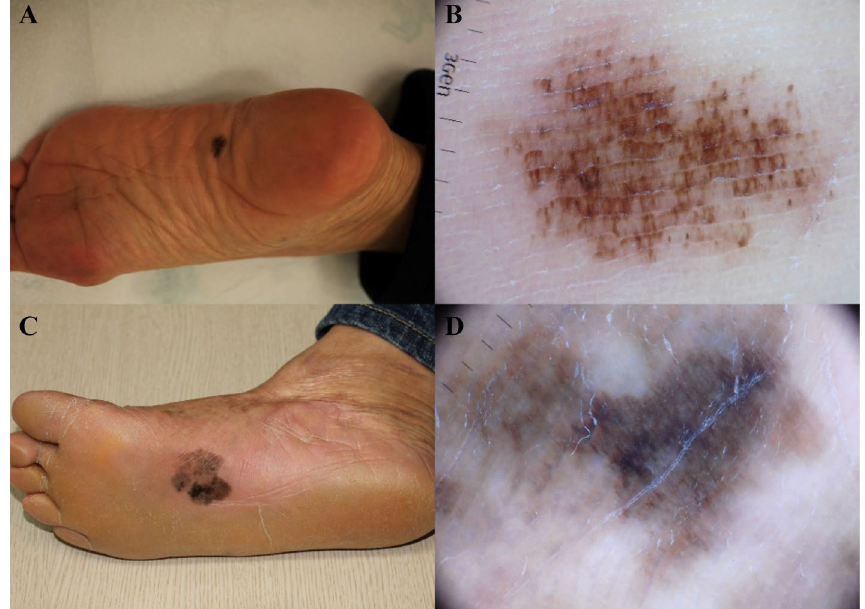
Figure 1. Clinical and dermoscopic features of acral lentiginous melanoma in situ (ALMIS): small versus large ALMIS. (A,B) The 12-mm ALMIS showed asymmetry, irregular dots and globules, and irregular fibrillar pattern. (C,D) The 31-mm ALMIS showed asymmetry, parallel ridge pattern, and irregular diffuse